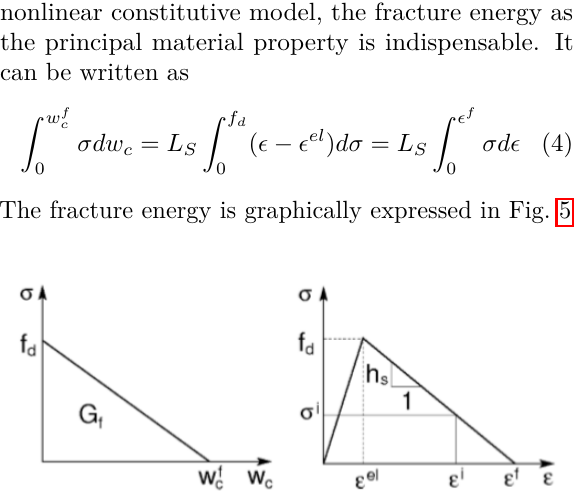
Figure 2. (A) Cross section of yarns with coordinate system, (B) Example of mesh of yarns in composite.